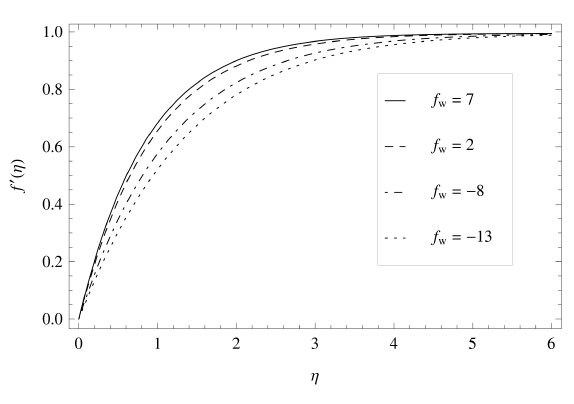
Fig. 2: The influence of a parameter α on f (cid:48) ( η ) for λ = 0.01, We = 0.2, M = 0.3, f = 0.01 and (cid:126) = −0.01. w